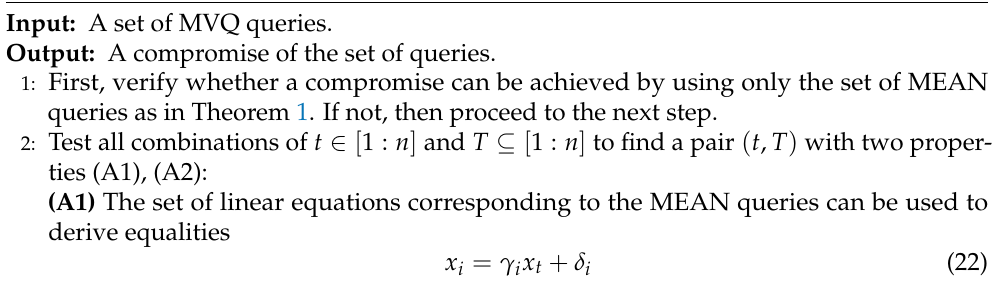
Algorithm 1 Quadratic Equation Attack.